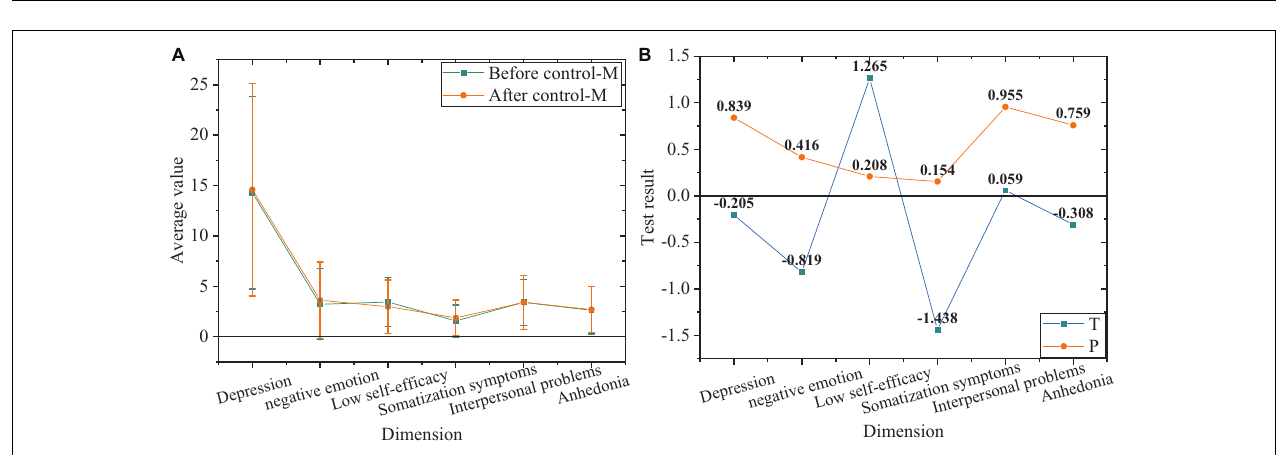
FIGURE 7 | Comparison of negative emotions. (A) The treatment group before and after the experiment. (B) Value of T and P of the treatment group before and after the experiment. ∗ Denotes a significant difference, while ∗∗ represents a highly significant difference.